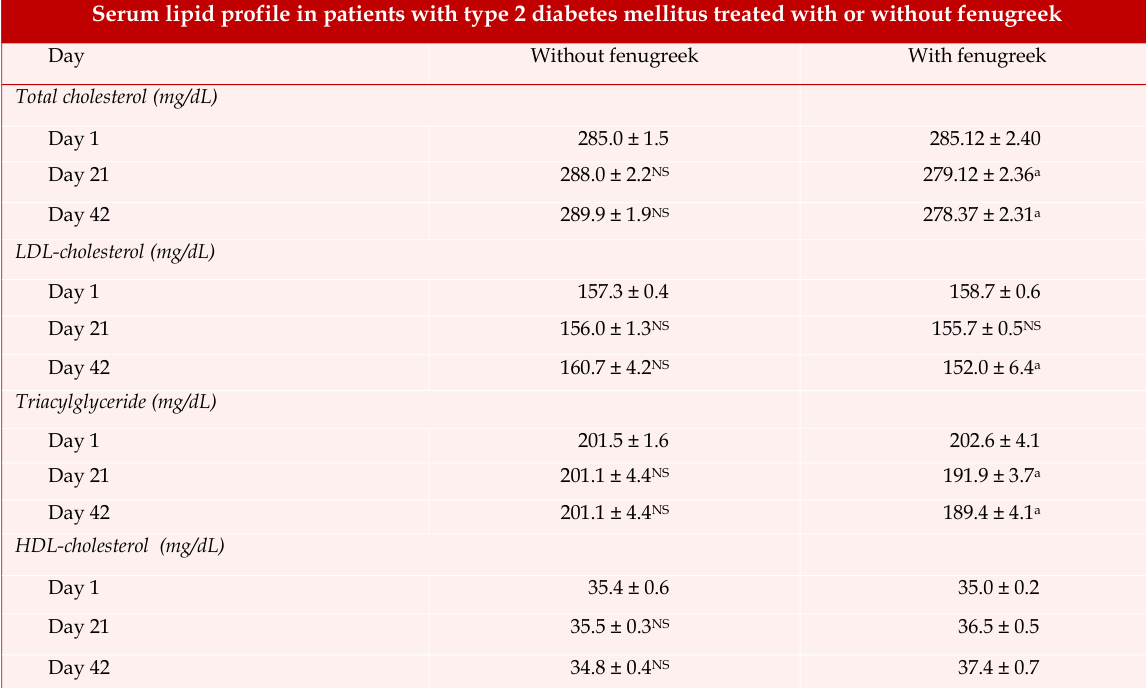
Serum lipid profile in patients with type 2 diabetes mellitus treated with or without